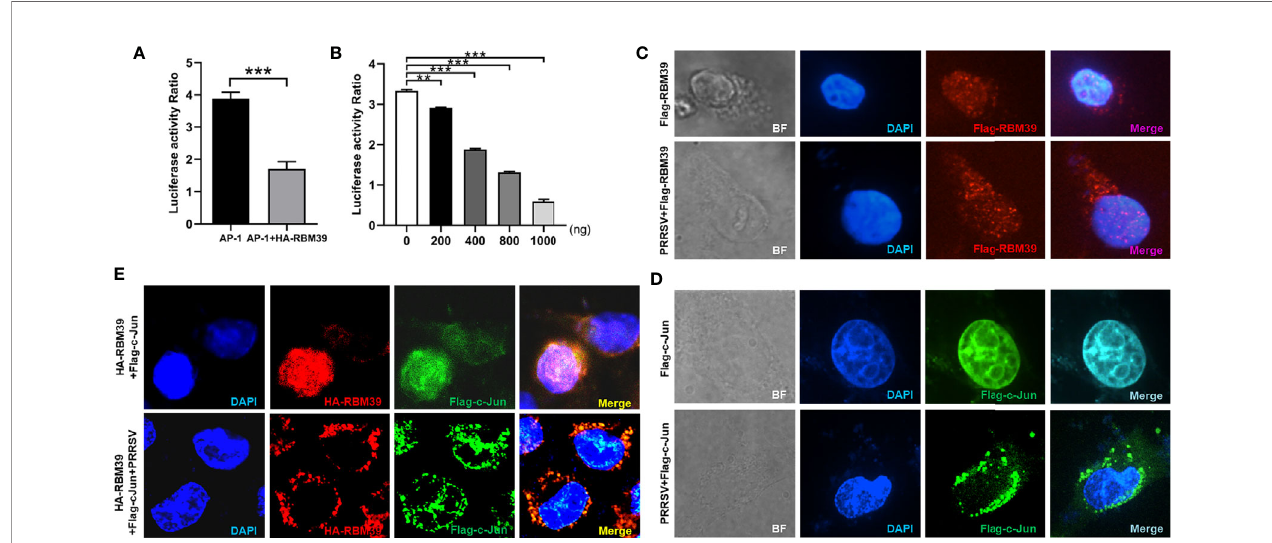
FIGURE 6 | RBM39 down-regulates AP-1 signaling pathway and PRRSV infection triggers out of the nucleus of translocation of RBM39 and c-Jun. (A, B) HEK293 T cells were transfected or co-transfected with AP-1 promoter reporter plasmid and different concentrations of HA-RBM39. The luciferase activity of AP-1 promoter reporter gene was measured through Dual Luciferase Reporter Gene Assay Kit (Yeasen Technology). (C – E) The 3D4/21cells were respectively transfected or co- transfected with HA-RBM39 and Flag-c-Jun plasmids, the cells were infected with 0.4 MOI PRRSV 12 h post-transfection. After 24 h, cells were incubated with rabbit anti-HA mAb and mouse anti-Flag antibody followed by FITC-conjugated goat anti-rabbit IgG (green) or IF555-conjugated goat anti-mouse IgG (red) antibody. Nuclei were stained with Hoechst 33258 dye (blue). Interaction and nuclear localization of RBM39 and c-Jun were observed using Laser confocal fl uorescence microscope. Data are representative of results from three independent experiments. The statistically signi fi cant at P-value was demonstrated in Statistical Analysis